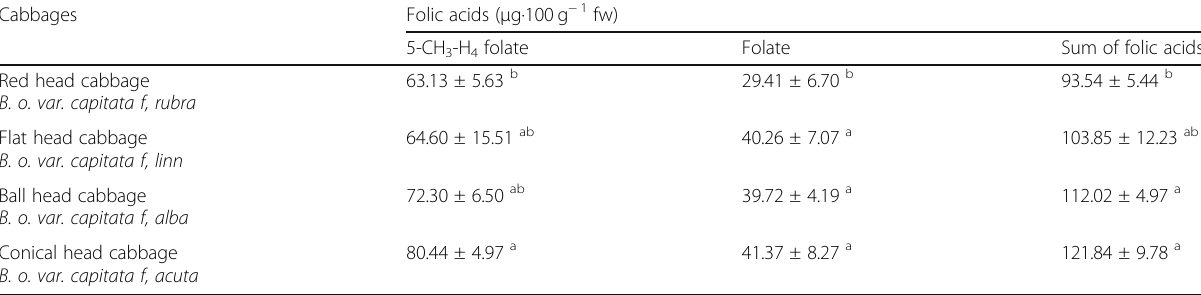
Table 2 The contents of folic acids in cabbage samples